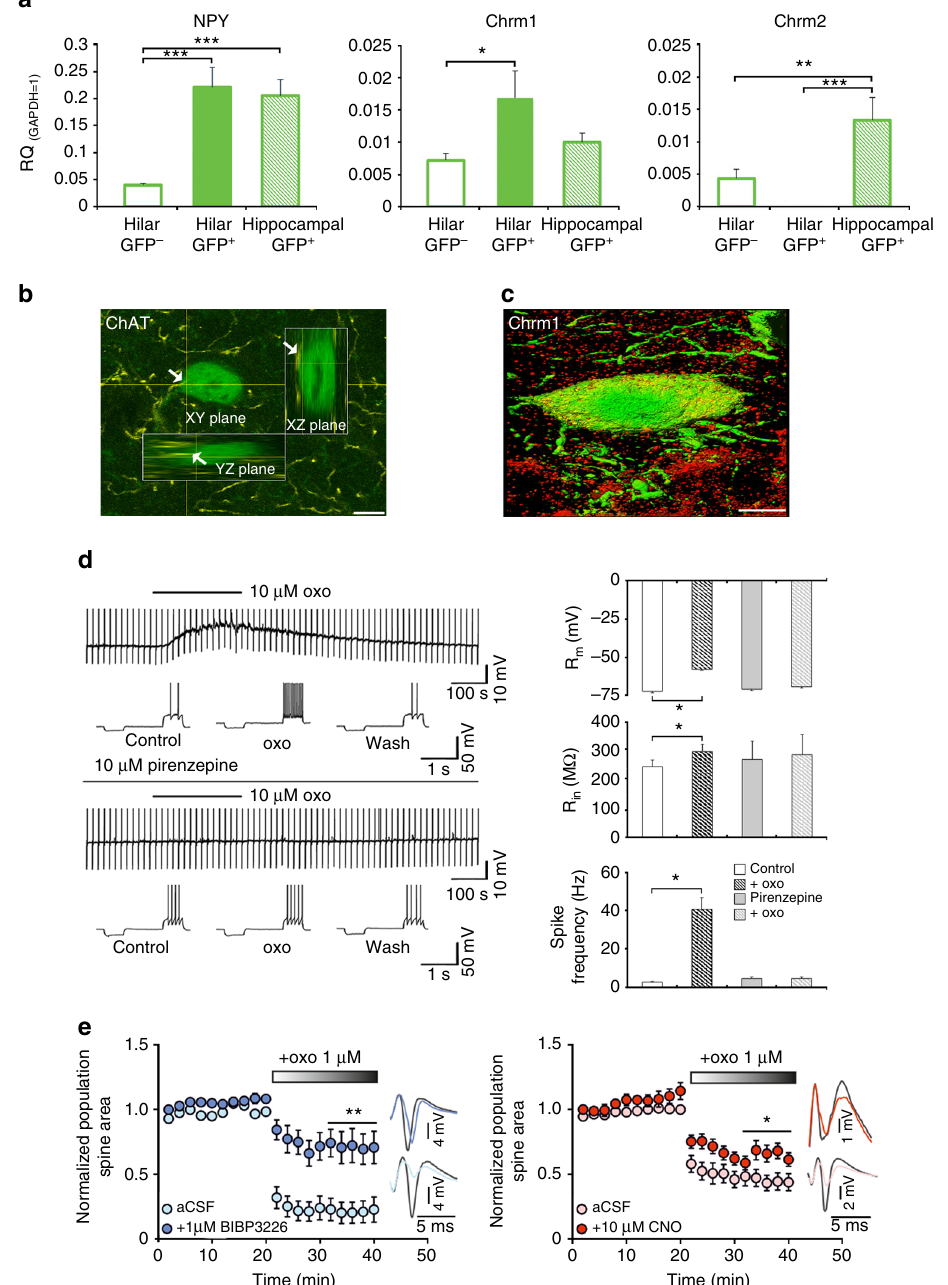
Fig. 4 Chrm1 expression and function in HIPP cells. a Hilar GFP + cells of NPY-GFP mice ( n = 6 – 8) are enriched with mRNA for NPY and M1 muscarinic receptors (Chrm1) but not M2 receptor (Chrm2). Values are expressed relative to the housekeeping gene GAPDH. b A 3D-reconstruction of a GFP + neuron targeted by cholinergic fi bers ( arrows ) at the soma. Scale bar, 10 μ m. c A GFP + neuron ( green ) in the dorsal hilus of an NPY-GFP mouse with somatic immunolabeling of M1 receptors ( red ). Scale bar, 5 μ m. d ( Left ) Representative current-clamp recording from GFP + interneurons. Application of 10 µ M oxotremorine M (oxo) induces a pirenzepine-sensitive transient depolarization paralleled by a signi fi cant increase in input membrane resistance and an increase in spike activity. ( Right ) Quanti fi cation of spike activity. Oxo induces a transient membrane depolarization from resting membrane potential in 7 out of 7 recorded neurons, paralleled by a signi fi cant increase in input membrane resistance and mean spike frequency elicited by positive current injections. These effects are abolished in the presence of the M1 receptor antagonist pirenzepine (10 μ M; n = 5). e In fi eld recordings, either Y1 receptor blockage ( left ) ( n = 6 slices with BIBP3226 and n = 6 slices without BIBP3226) or pharmacogenetic HIPP cell inactivation ( right ) ( n = 8 slices with BIBP3226 and n = 10 slices without BIBP3226) counteracts the depression of population spikes induced by oxo bath application. Example traces to the right of the graph illustrate the difference in response to perforant path stimulation. Values are means ± s.e.m. Statistical analysis was done with Fisher ’ s LSD following one-way ANOVA in a , Wilcoxon signed rank test in d and Student ’ s unpaired t -test in e . * P < 0.05; ** P < 0.01; *** P <